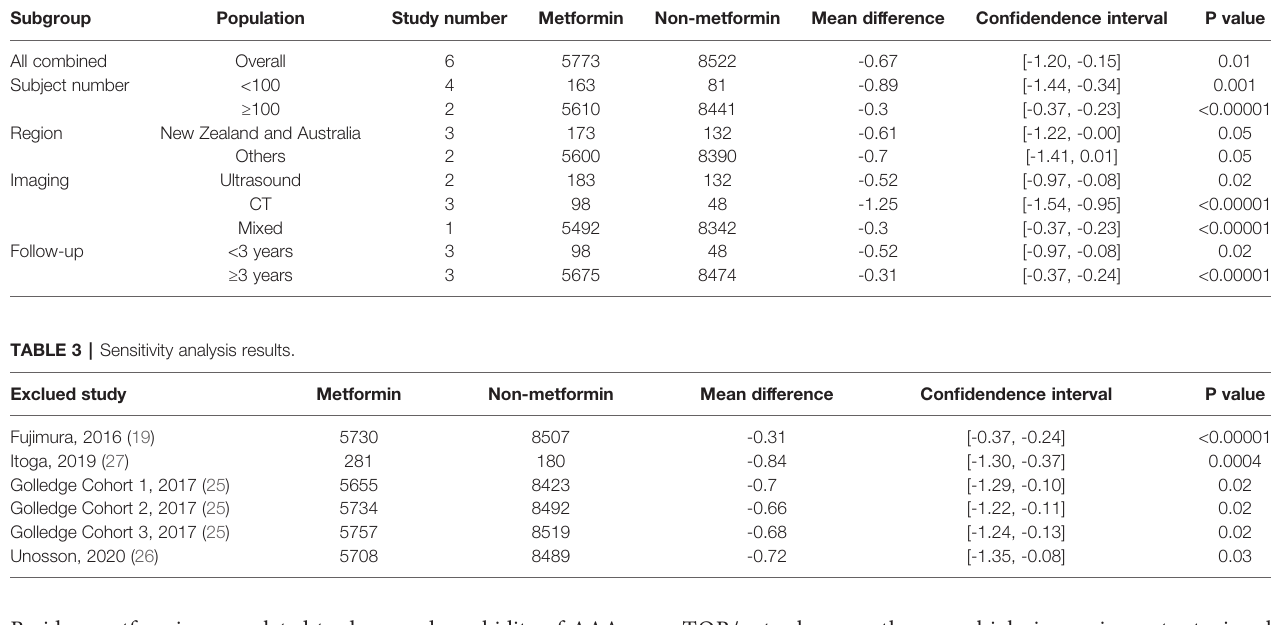
TABLE 2 | Subgroup analysis results. Subgroup